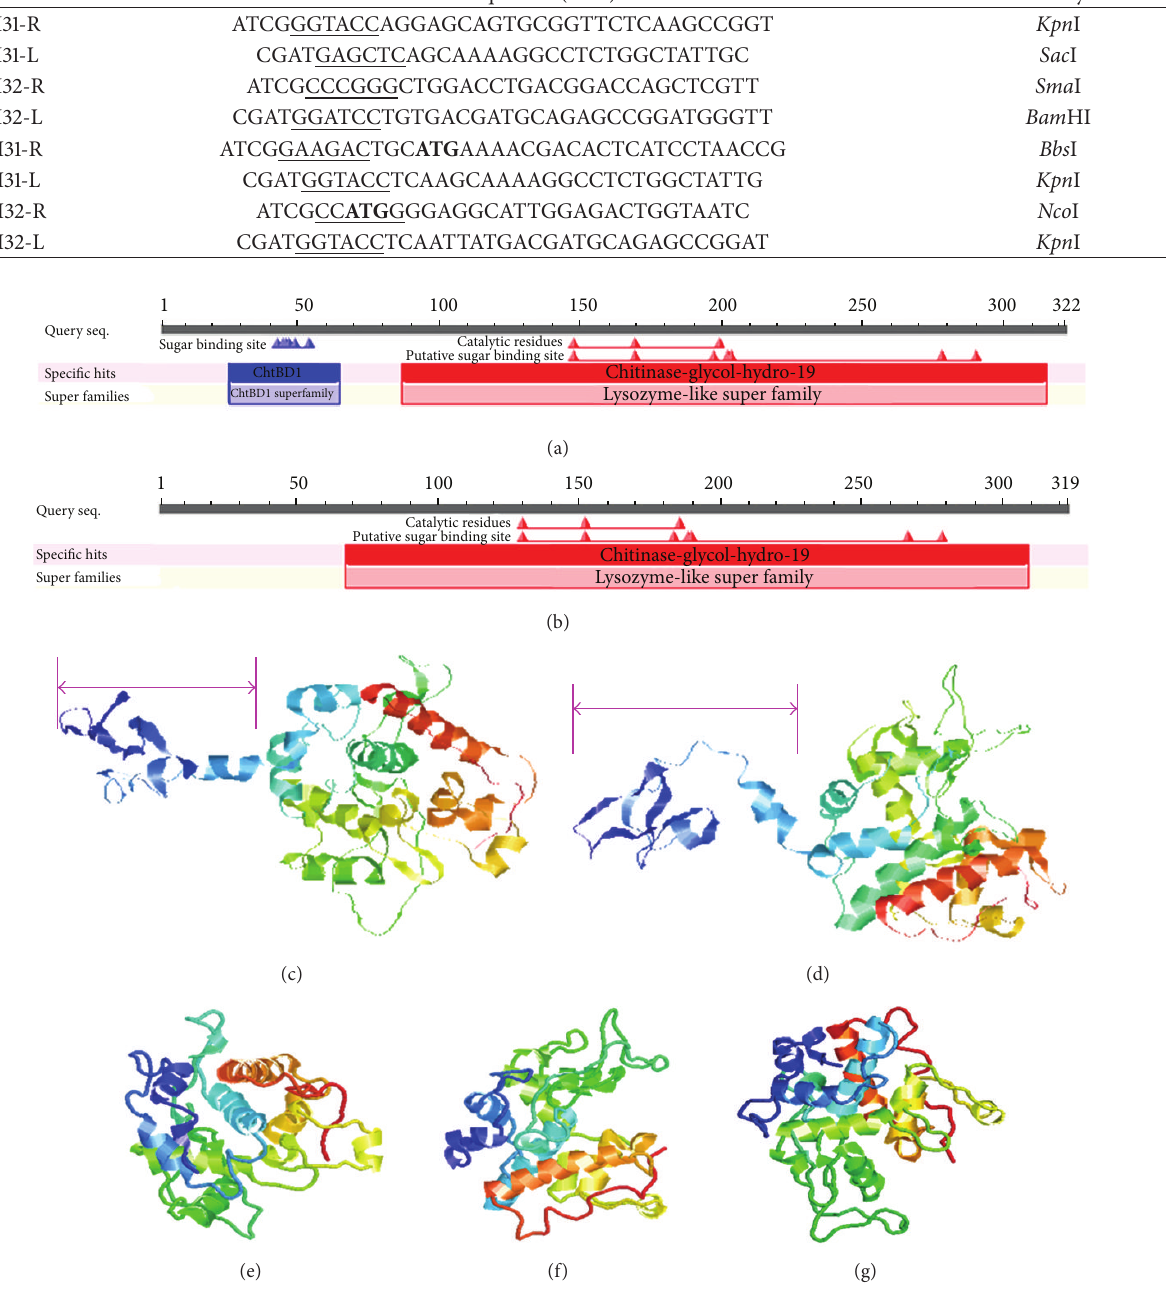
Figure 1: Protein families and the three-dimensional structures of LbCHI31 and LbCHI32 chitinases from L. bicolor . (a) Protein family of the LbCHI31 chitinase; (b) protein family of the LbCHI32 chitinase; (c-d) three-dimensional structure of LbCHI31 chitinase; (e–g) three- dimensional structure of the LbCHI32